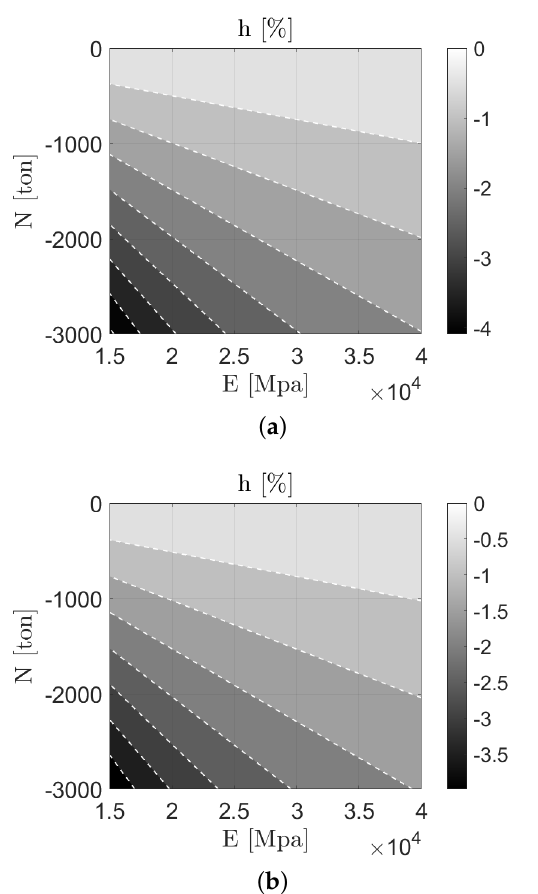
Figure 4. Percentage variation of the natural frequency in externally prestressed beams expressed by the h ratio in Equation (10), given two sample cases ( a ) with A = 6 m 2 , I = 4 m 4 , ν = 0.2, ρ = 2500 kg/m 3 and ( b ) with A = 2 m 2 , I = 4 m 4 , ν =0.2, ρ = 2500 kg/m 3